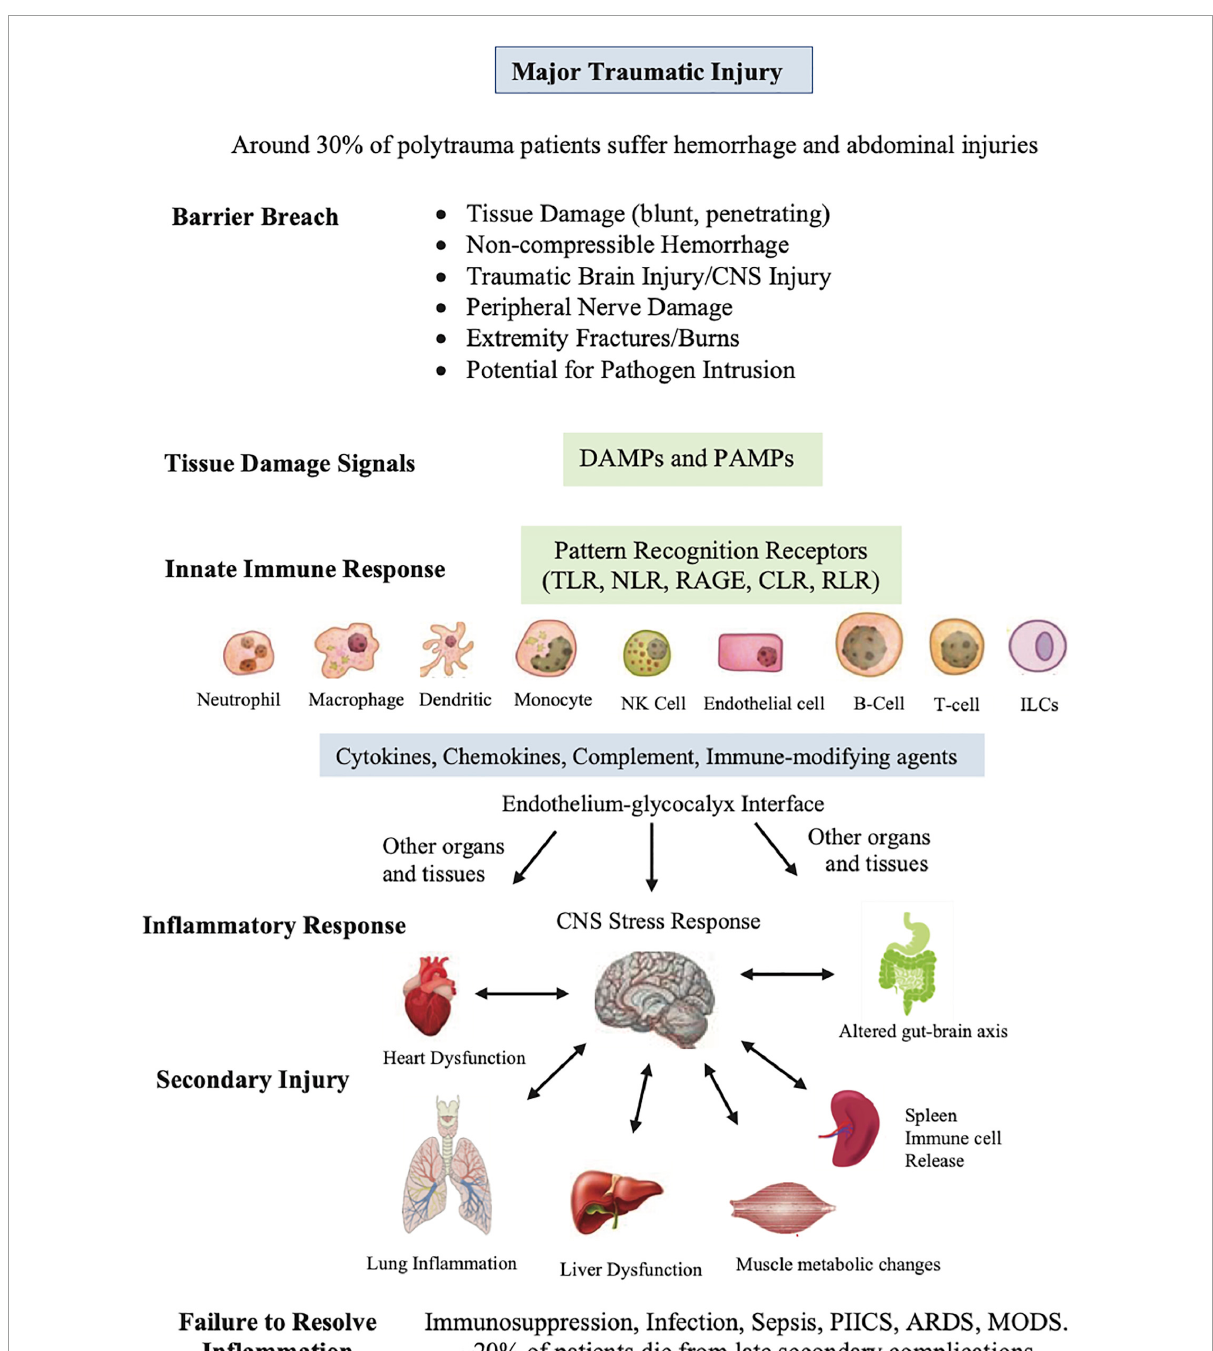
FIGURE2 Sequence of events that occur after major traumatic injury. This diverse group of innate cells resident in the tissues detect and respond to changes in the local environment, including damage associated molecular patterns (DAMPs), pathogen associated molecular patterns (PAMPs), neural signals, and other immune-modifying triggers. The pattern recognition receptors on these cells include Toll-like receptors (TLRs), C-type lectin receptors (CLRs), nucleotide-binding oligomerization domain (NOD)-like receptors (NLRs), retinoic-acid-inducible gene-I (RIG-I)-like receptors (RLRs), and receptor for advanced glycation end products (RAGE). PAMPs can be derived from viruses, opportunistic bacteria, fungi, and protozoa and helminths. The innate cells orchestrate an immune response to response to the barrier breach by releasing different inflammatory factors. If dysregulated, the response can lead to secondary injury to the CNS and major organs of the body. The spleen has been included as it is reservoir of platelets, peripheral macrophages, undifferentiated monocytes and other immune cells. ILCs, innate lymphoid cells; NK, natural killer cells, PIICS; Persistent Inflammation, Immunosuppression and Catabolism Syndrome, ARDS; acute respiratory distress syndrome, MODS; multiple organ